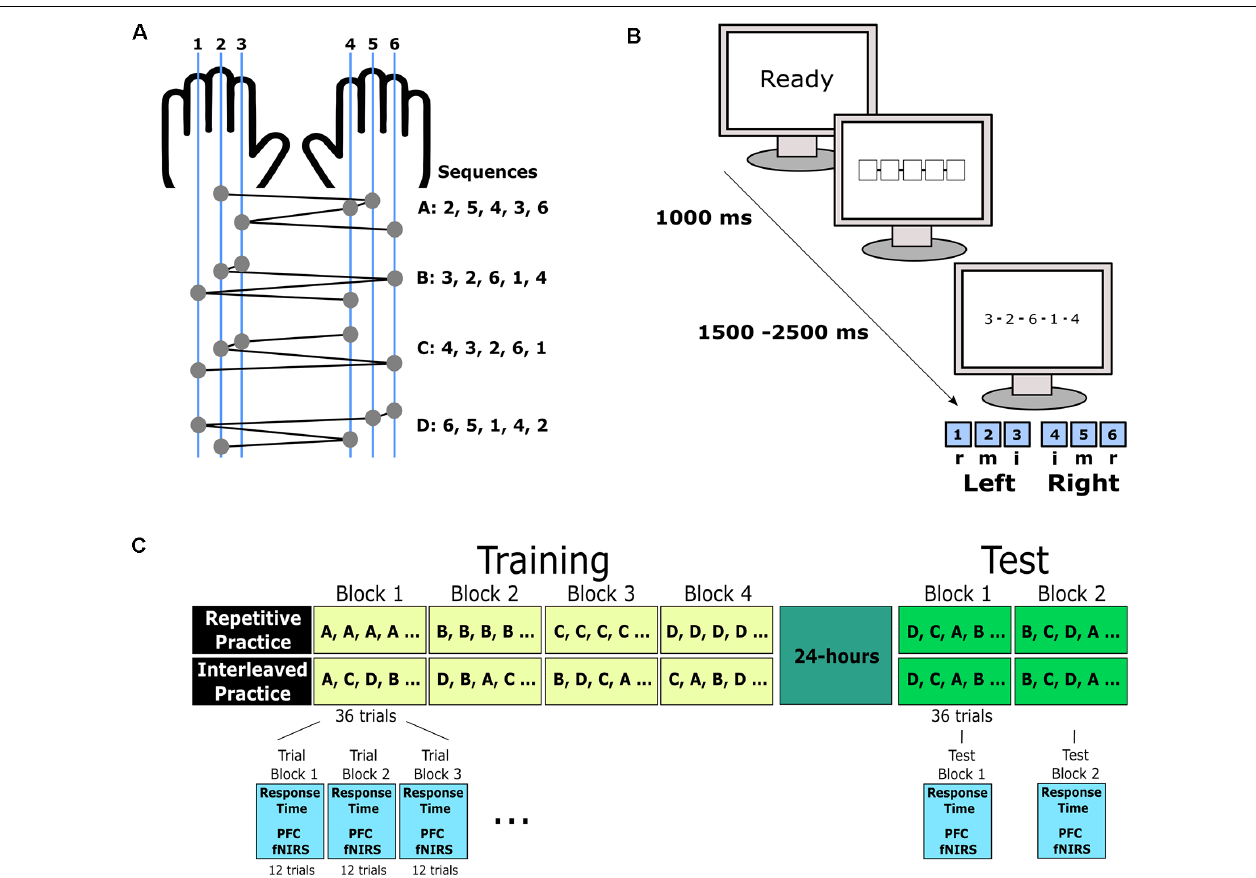
FIGURE 1 | Sequence learning involved four bimanual five-item key press sequences (A) . In each training and test trial, a “Ready” warning signal preceded a fixation stimulus involving five boxes. After a random interval, the response stimulus was presented based on a sequence of numbers that represented the order that each of the keys was to be pressed. The five keys were numbered one to five from left to right on the keyboard. Keys were pressed by either the index (i), middle (m), or ring (r) finger of the left and right hand (B) . The four sequence variations were trained across four training blocks. Under repetitive practice, one sequence variation was practiced in each training block, whereas for interleaved practice, all four sequences were performed in a block following a pseudo-random order given a sequence could not be repeated in consecutive trials. The order of sequences under RP was counterbalanced. The training involved four blocks of 36 trials. For the purpose of analysis, each block was divided into three trial blocks consisting of 12 trials each. This resulted in 12 trial blocks for analysis. Approximately 24 h after training completion, participants completed two test blocks of 36 trials each. For the test, the four sequence variations were presented in a pseudo-random order (C) .